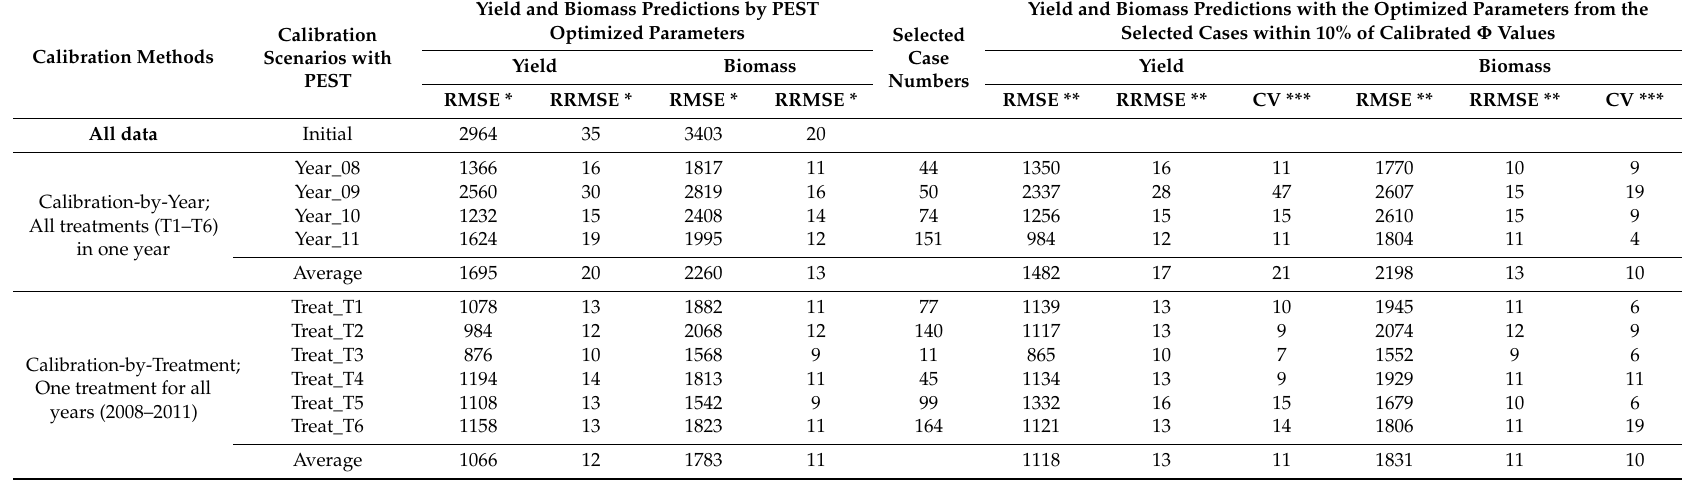
Table 4. The RMSE (root mean square error, kg ha − 1 ) and relative RMSE (RRMSE, %) values for yield and biomass predictions using Parameter ESTimation (PEST) optimized cultivar parameters or LHS sampled cultivar parameters (11–164 cases with Φ values within 10% of calibrated minimum Φ values), for the Calibration-by-Year and Calibration-by-Treatment. Yield and Biomass Predictions with the Optimized Parameters from the Selected Cases within 10% of Calibrated Φ Values Yield Biomass Yield